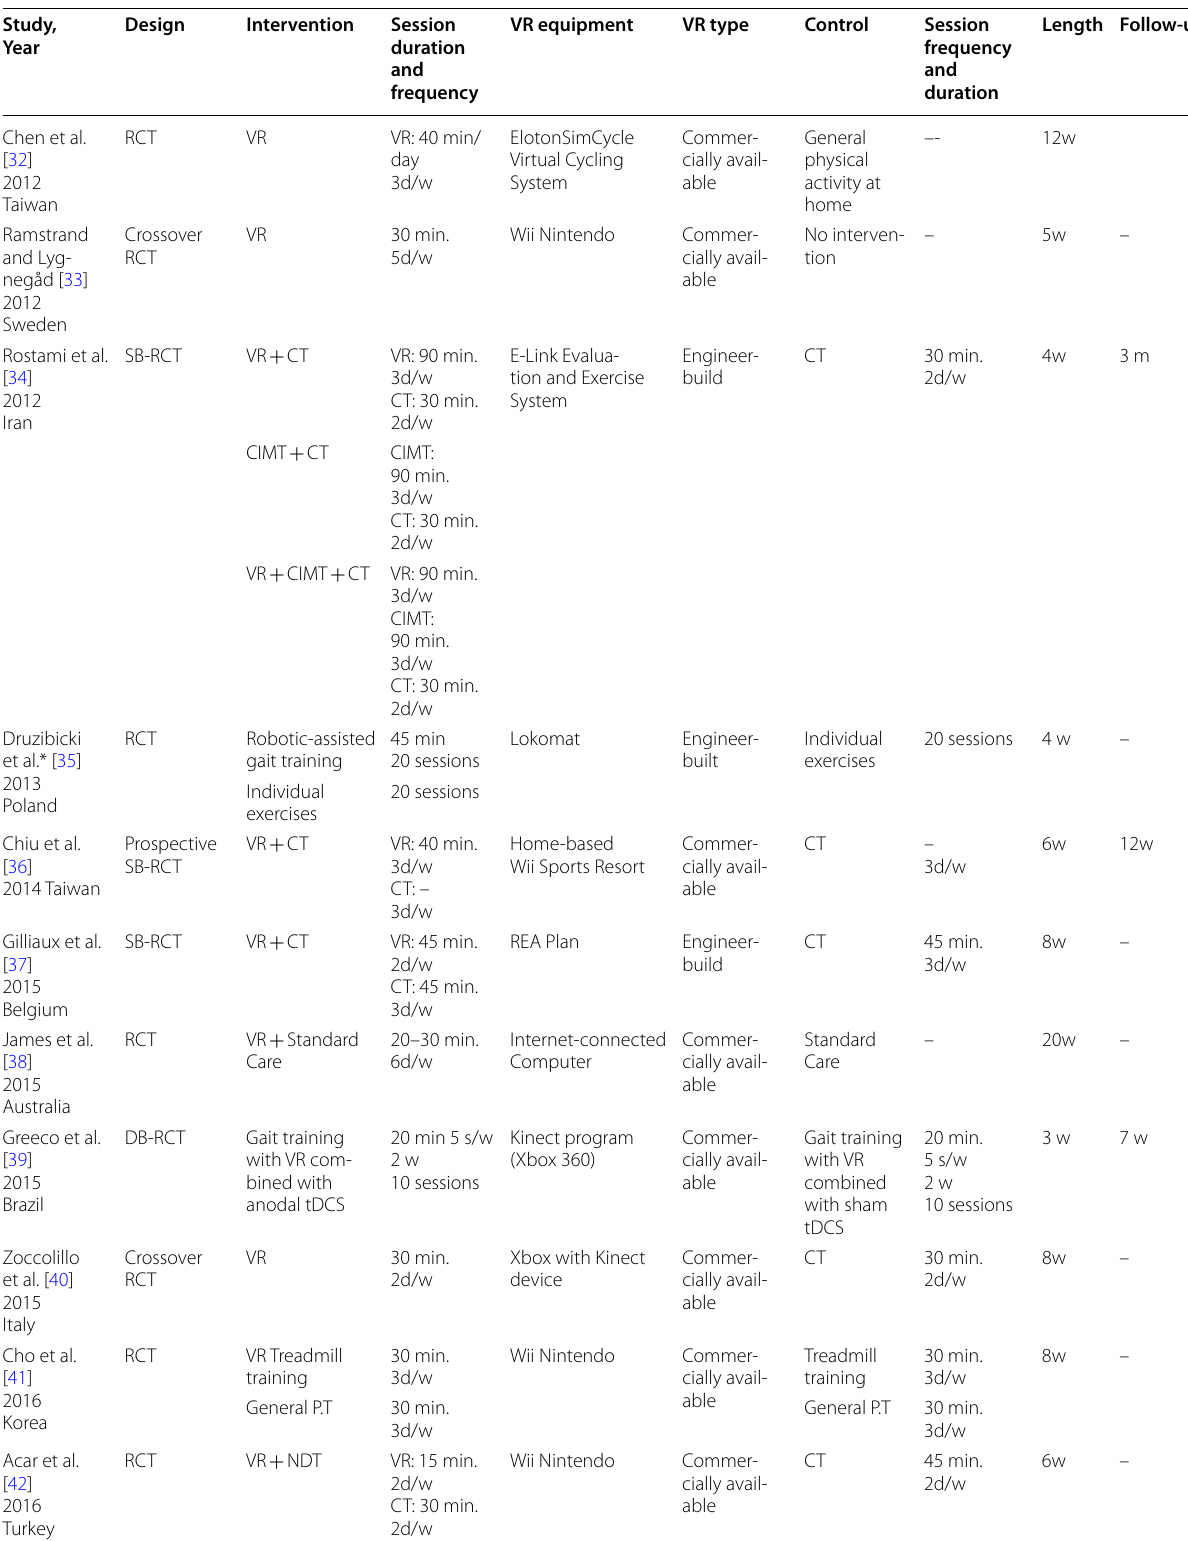
Table 2 Studies